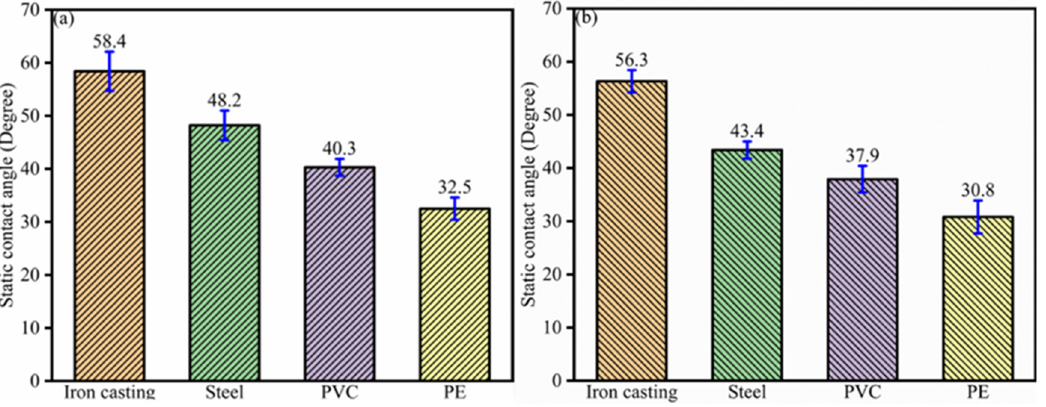
Figure 2. The static contact angles of water drop onto the iron casting, steel, PVC, PE ( a ) without vibration; ( b ) with 300 Hz vibration.